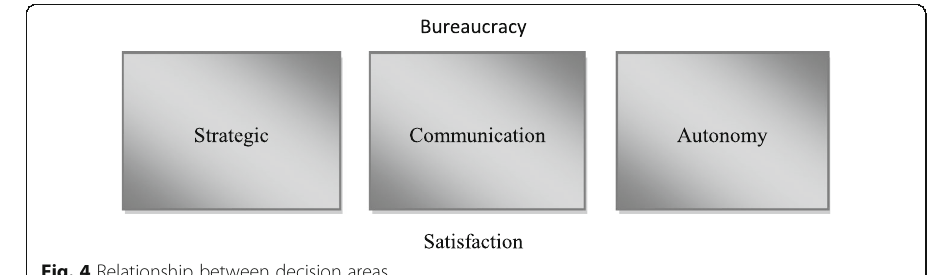
Fig. 4 Relationship between decision areas